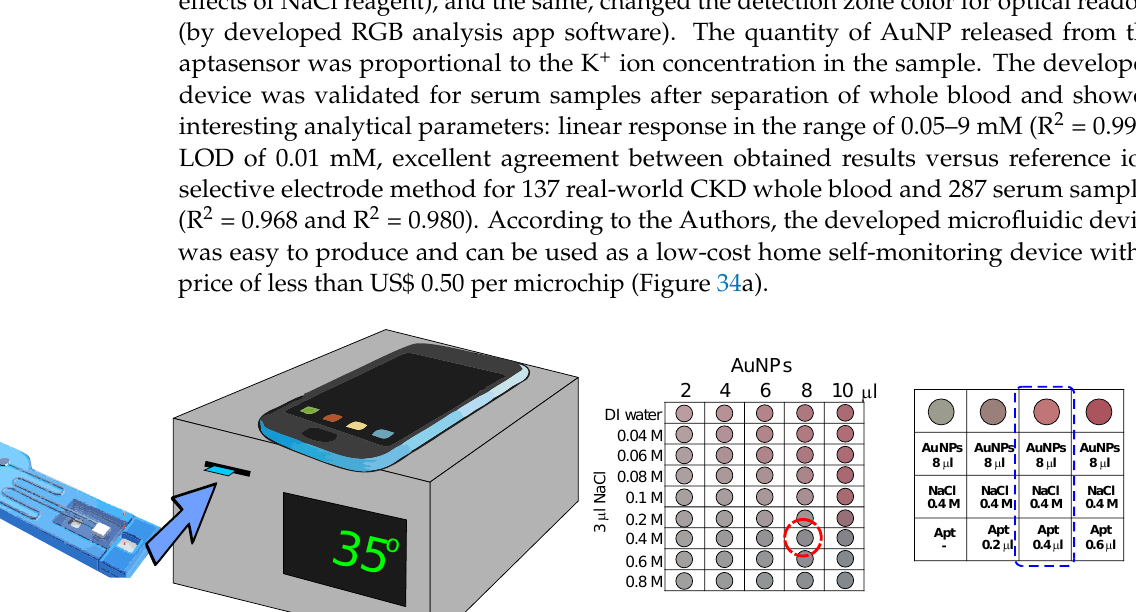
( c ) Figure 33. ( a ) The structure of Ag-DNA aptamer reversibly changes through binding and dissociat- ing the silver ions ( b ) The volume change of the DNA aptamer-linked hydrogel as the sensor re- sponse toward 10 mM Ag + ions. The scale bar is 500 μm ( c ) Scheme of the DNA aptamer-linked hydrogel sensor integrated with the microfluidic heating device for repeatable detection of chemical substances [120]. The demand for microflow devices dedicated to automatic detection and quantifica- tion of chosen ions is undeniable, and the best example of such is the one developed by